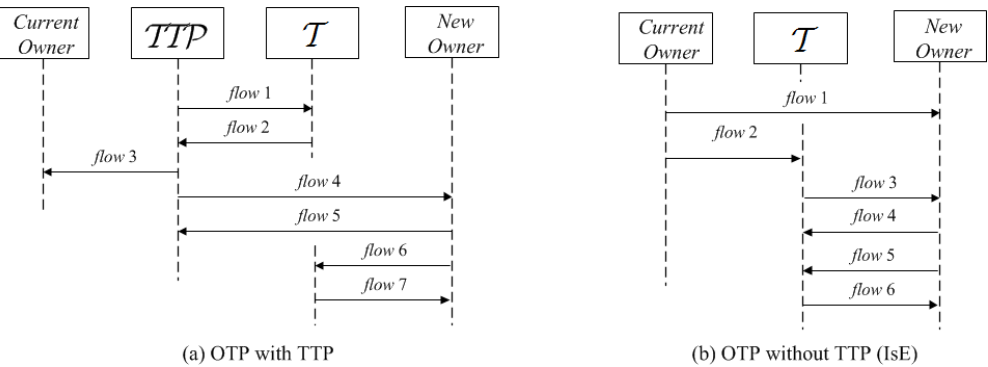
Figure 1. Example sketches of ownership transfer protocols (OTPs) with trusted third parties (TTPs) ( a ) and without TTPs (isolated environment) ( b )